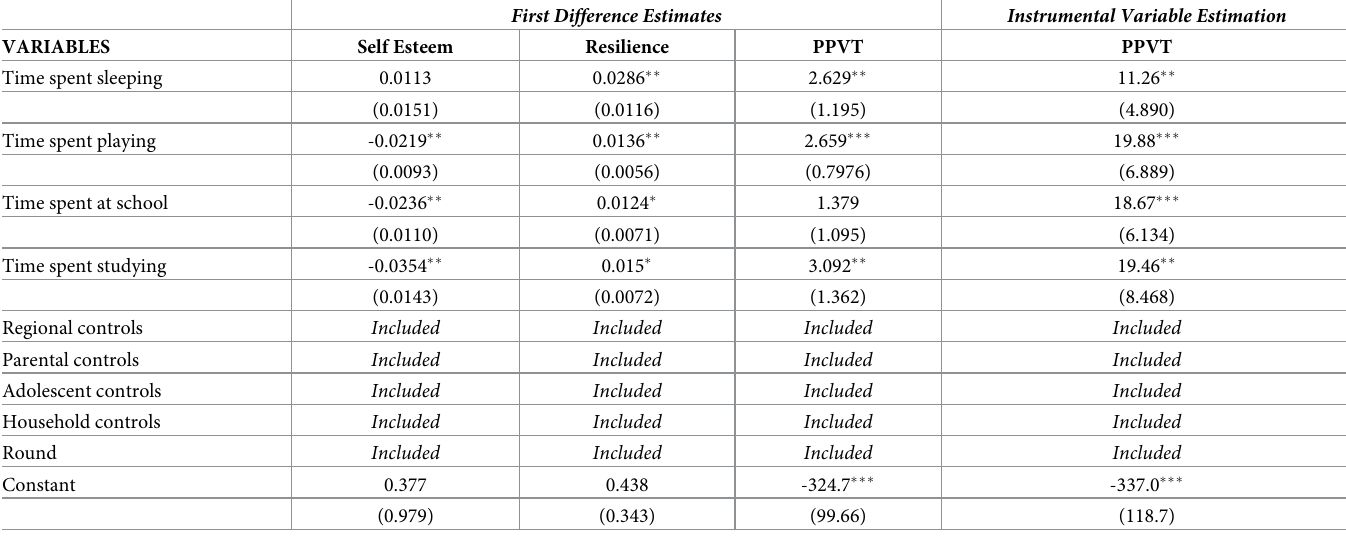
Table 4. First difference and instrumental variable